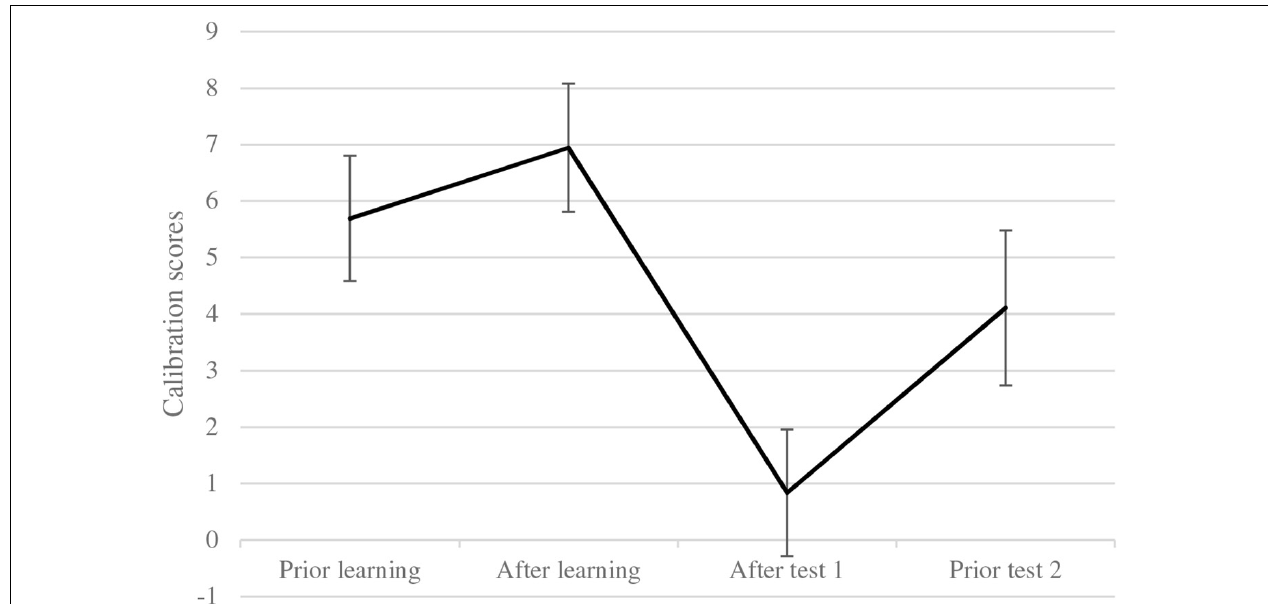
FIGURE 9 | Main effect of calibration accuracy. Error bars represent the standard error of the mean.